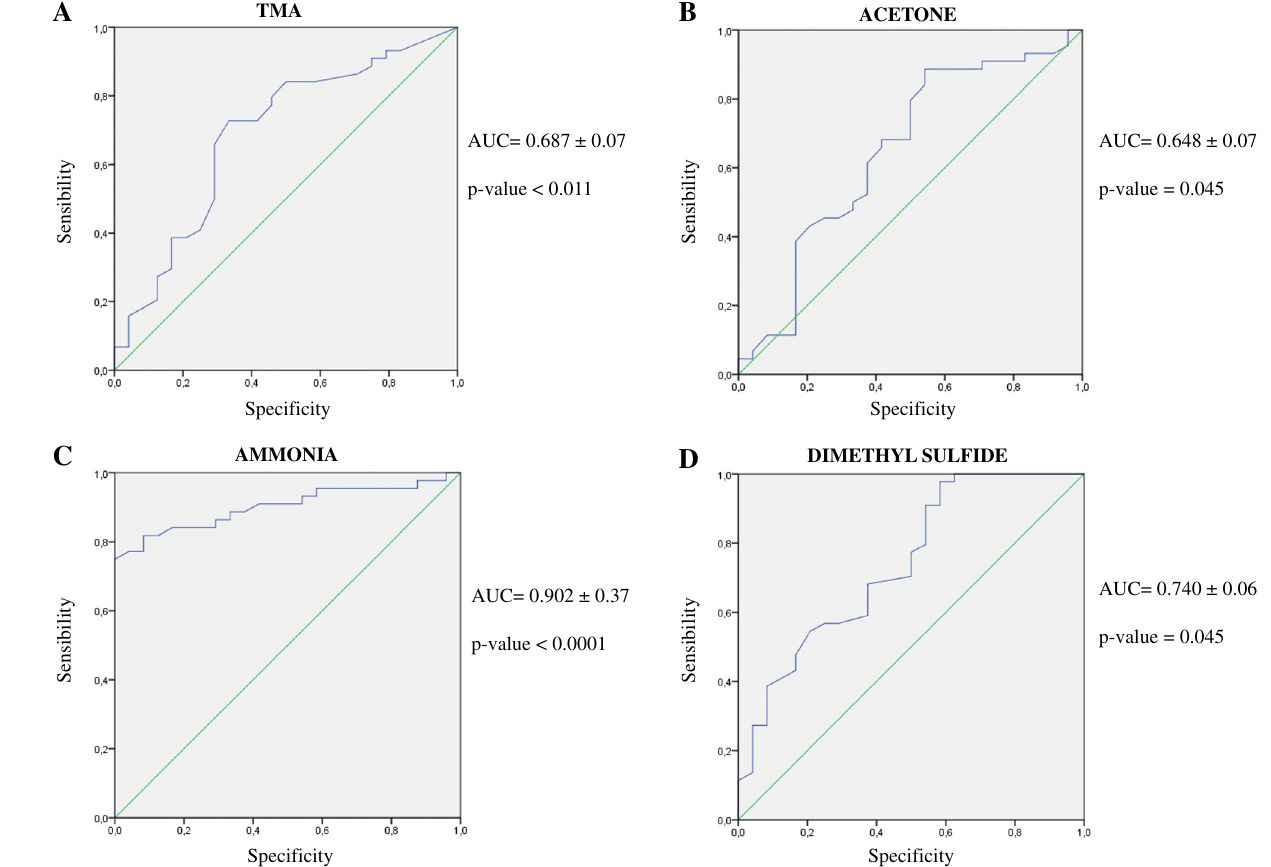
Figure 1. ROC curves: AUC and p values of TMA ( A ), acetone ( B ), ammonia ( C ) and dimethyl sulfide ( D ). Abbreviations: AUC area under the curve; TMA trimethylamine.